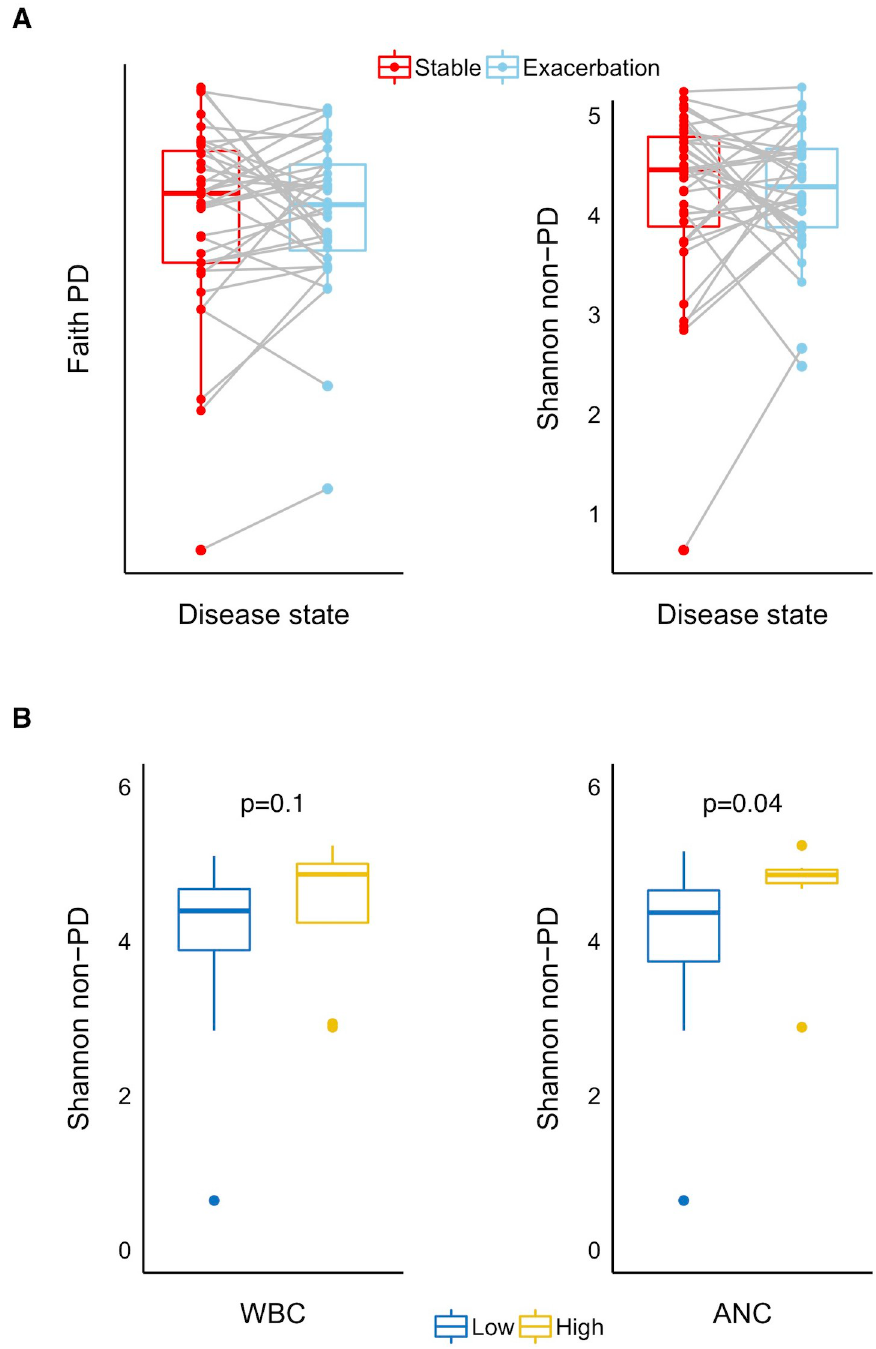
Fig 6. Alpha-diversity in induced sputum collected from 36 COPD patients. A: Comparison of phylogenetic (Faith PD) and non-phylogenetic (Shannon non-PD) alpha-diversity in sputum collected at stable state and during exacerbation. Lines connect samples from the same individual. Wilcoxon signed rank test was applied based on the paired, non-parametric data. B: Relations between Shannon’s alpha-diversity at stable state and serum inflammatory markers during exacerbations. WBC: White Blood Cell counts high > 11.3 10 9 /L (n = 8) ANC: Absolute Neutrophil Count high > 8.4 10 9 /L (n = 7). Kruskal Wallis test used due to non-parametric data. Boxes show the interquartile range (IQR = 75 th percentile-25 th percentile), with medians marked by the horizontal line within each box.